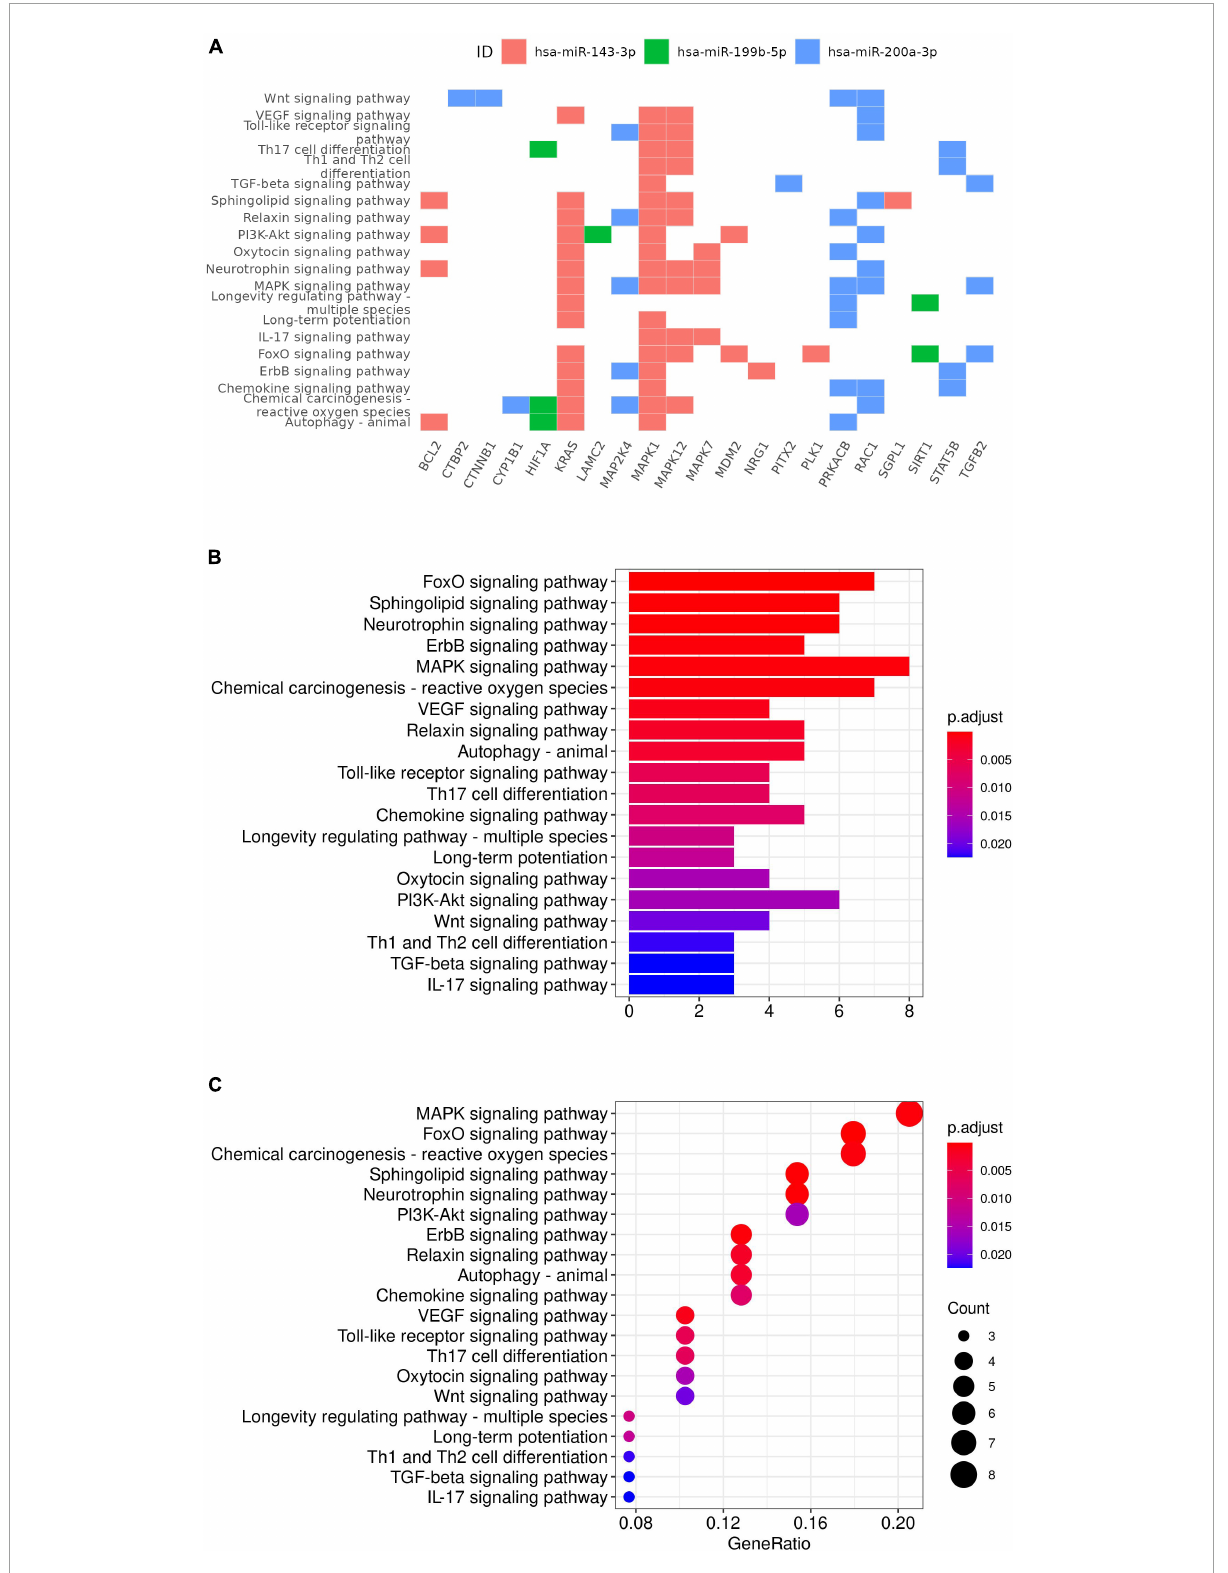
FIGURE4 KEGG gene set enrichment analysis results. Targets of miRNA were plotted against the enriched pathway (A) . Selected enriched gene sets were also plotted with p -value (B) and gene ratio (C) on x-axis.